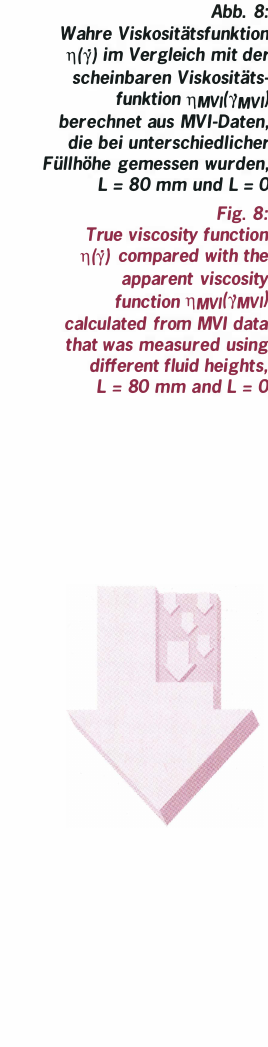
Fig. 8: True viscosity function n("l) compared with the apparent viscosity function 11MVI(1MVI) calculated from MVI data that was measured using different fluid heights, L = 80 mm and L =